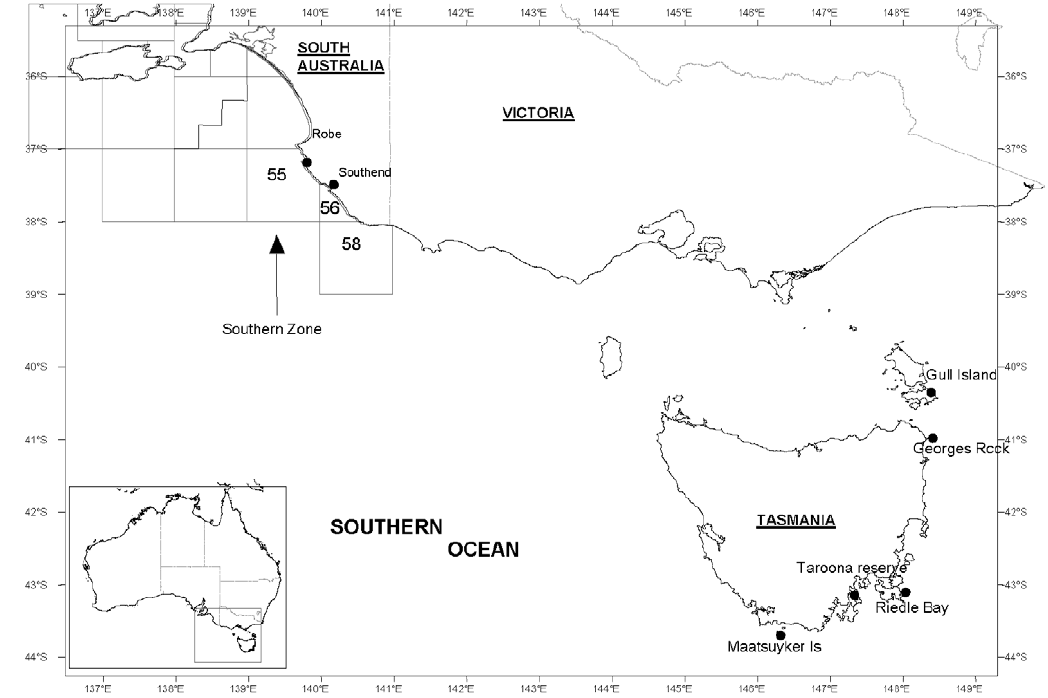
Figure 1. Map of study sites in South Australia and Tasmania. Inset is map of Australia.